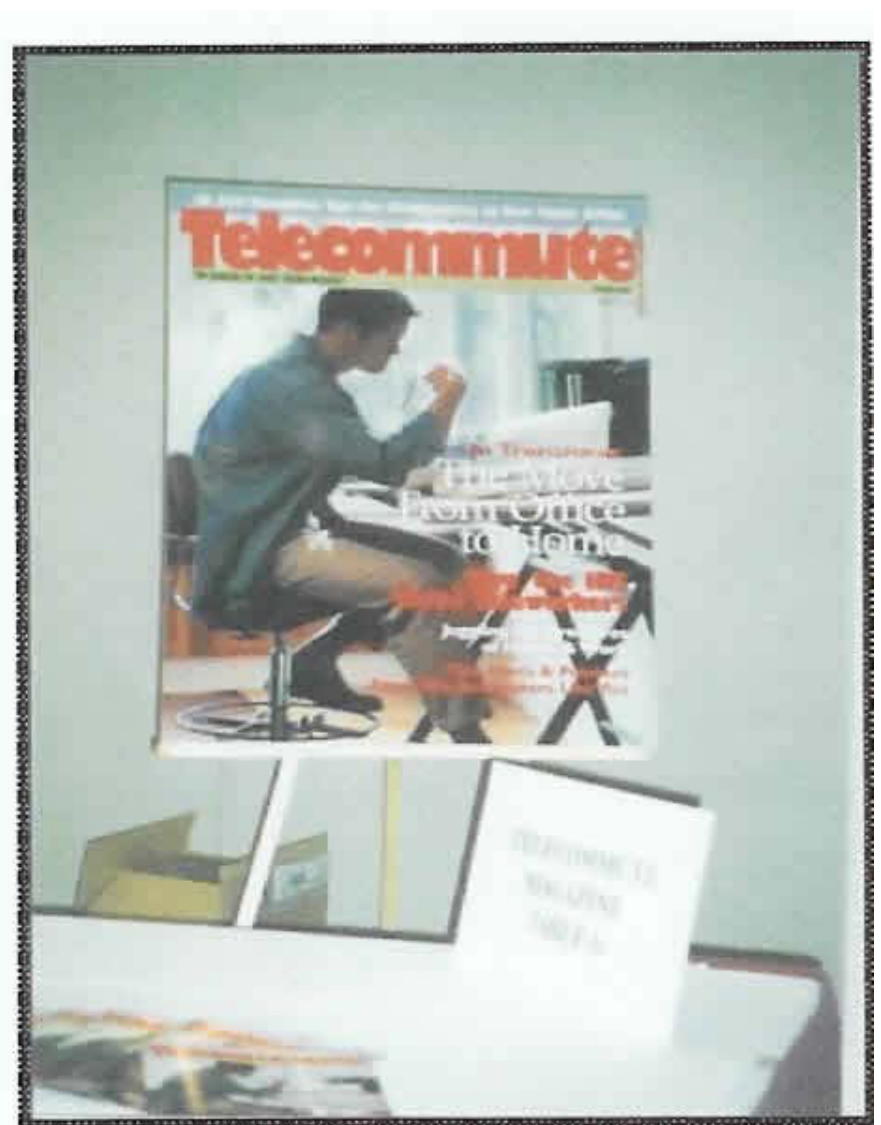
Figure 6 Telework publications (picture courtesy of ITAC